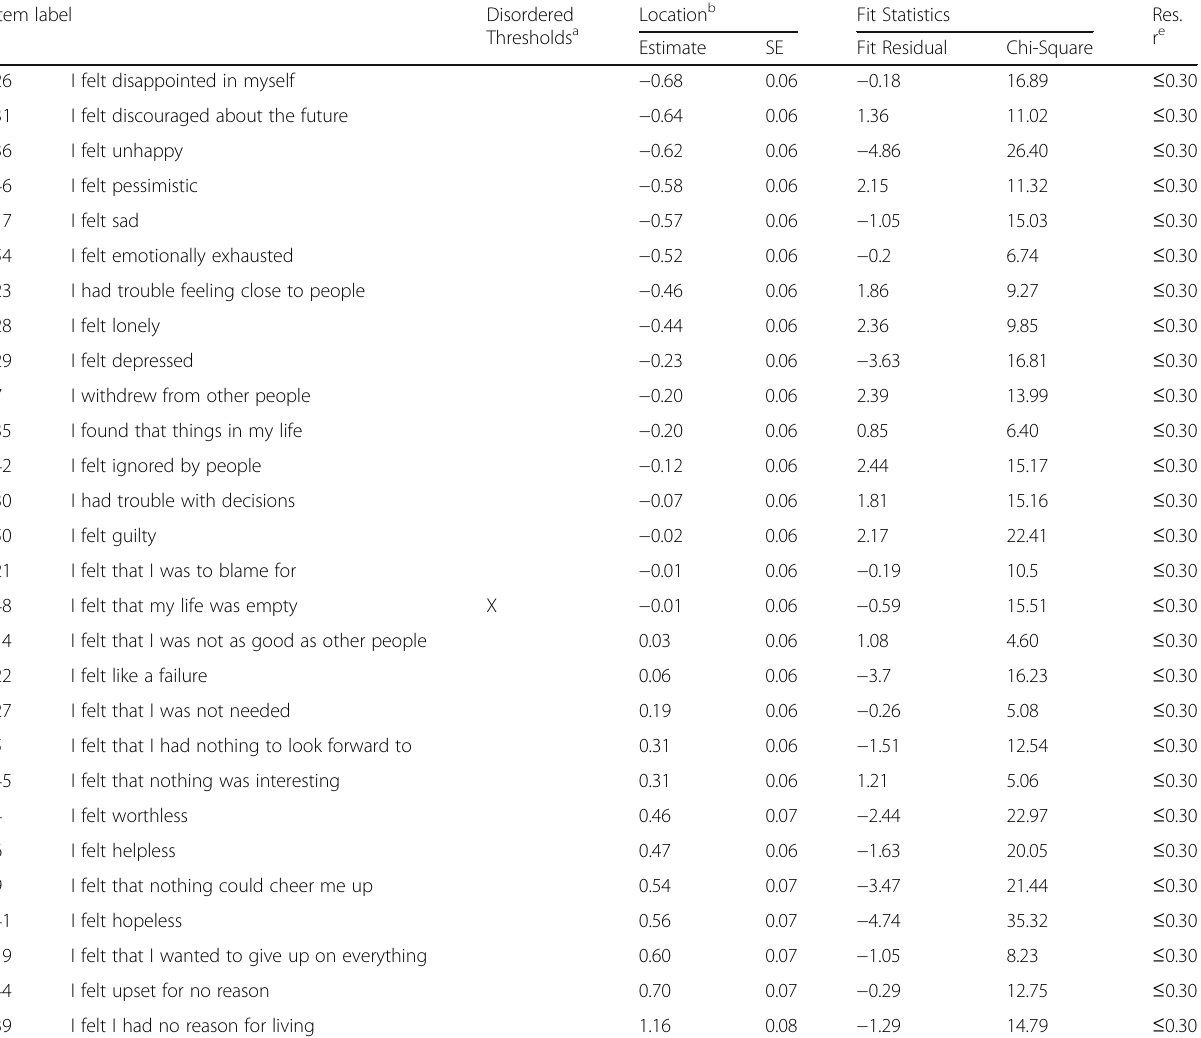
Table 3 PROMIS 28 Thresholds ordering, item location estimates, item fit statistics and item dependency Item